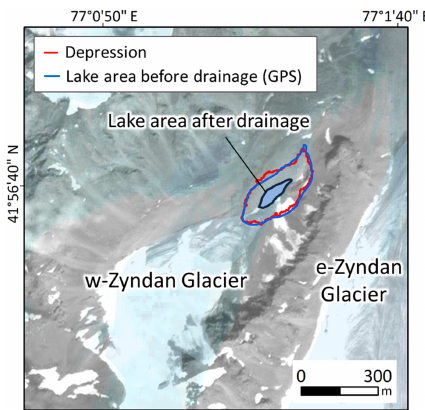
Figure 2. Western Zyndan glacial lake at which a large drainage event occurred on 24 July 2008 (location in Fig. 1). The blue line shows the lake perimeter before drainage, according to GPS mea- surements on 29 July 2008. The red line shows the depression, ac- cording to ALOS PRISM DSM